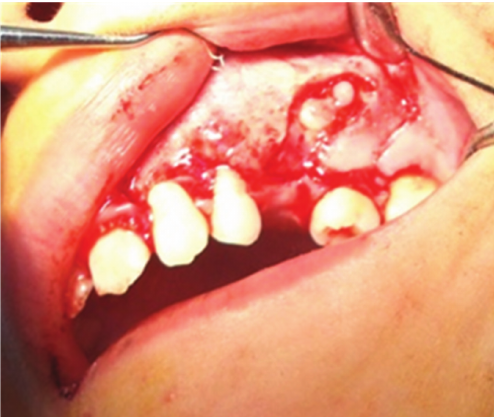
Figure 6: Canine tooth embedded within the cyst.